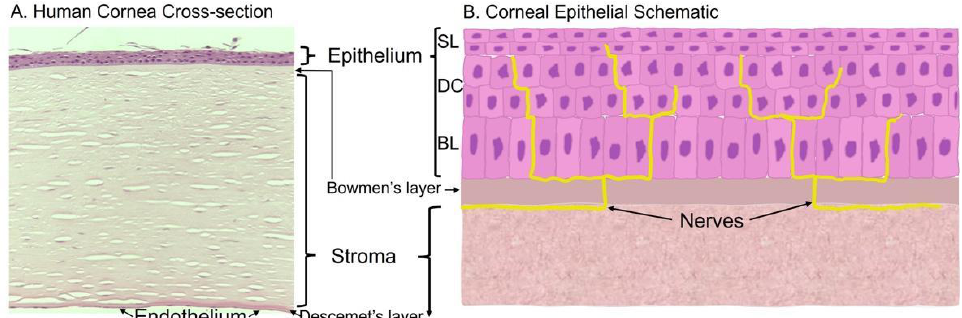
Figure 1. Histology and schematic of the cornea. ( A ) Human cornea obtained from cadaver donation. Corneal tissue was placed in 4% paraformaldehyde overnight, washed, and embedded in paraffin for histological sectioning and hematoxylin and eosin staining to visualize the various cell layers and membranes. ( B ) Schematic of the corneal epithelium that highlights the epithelial layers and innervation; BL = basal epithelial cells, DC = differentiated cells, SL = superficial